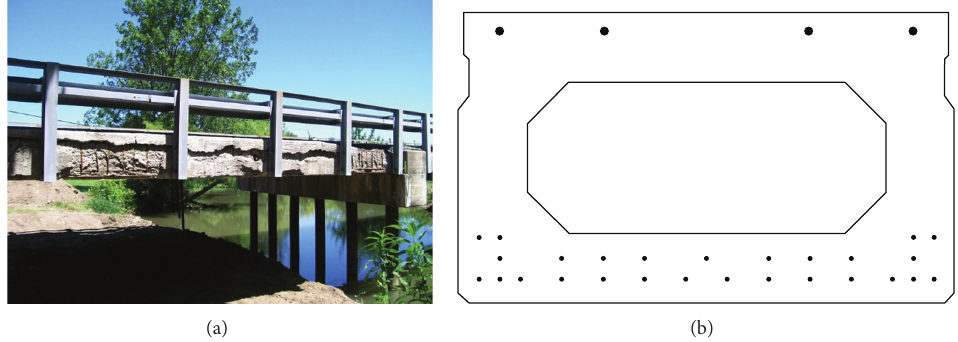
Figure 3: BR 35-17-6.80: (a) deterioration to the south side of end span and (b) typical cross section of box-beam.